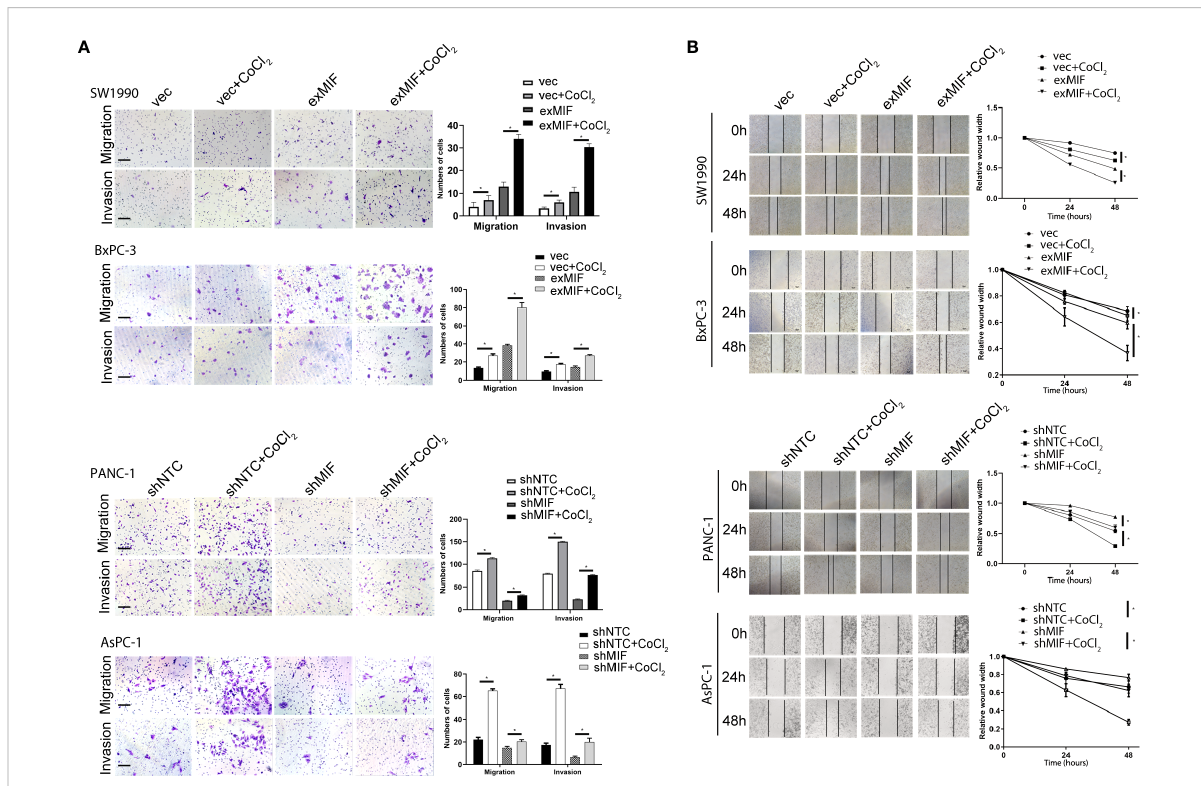
FIGURE 4 MIF promotes the invasion/migration of PDAC cells in vitro (A) Transwell migration and invasion assay. Images of migration and invasion of each cell group were presented. The migrating cells were stained with violet color. The bar charts showing the average migration and invasion cell number per fi eld among different experimental groups. Data are the mean ± SD from three independent experiments, * P <0.05. Scale bars, 100 µm. (B) Wound healing assay. Representative images showing the scratch at time 0 h, 24 h and 48 h of PDAC cells in indicated conditions. The line charts showing the quantitative analysis of the relative wound width. The values were normalized by the wound width at the same area of the scratch at time 0 h. * P <